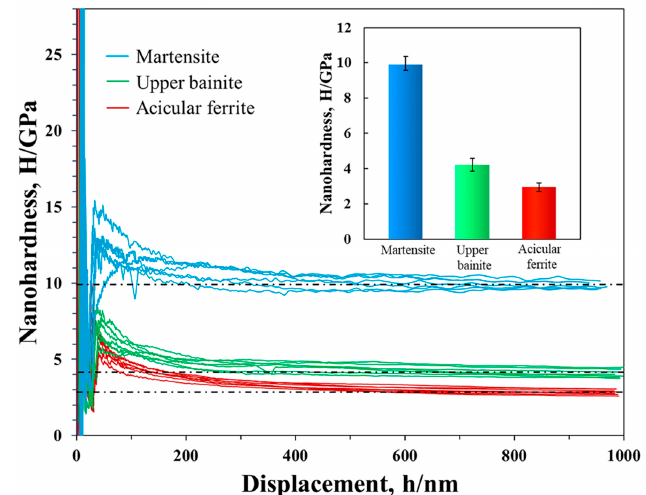
Figure 4. Nanohardness–displacement curves of the three microstructures. Average hardness for each microstructure was drawn from the flat lines in the displacement range between 600 and 1000 nm. The average nanohardness and its error value in each microstructure were shown in the top-right corner. Using our tested average nanohardness values and the Equation (3) derived by Rodriguez et al. based on stress–strain testing, we calculated the yield strength in each microstructure of the surface layer [41]. It was about 2378 ± 123 MPa for lath martensite, 1007 ± 94 MPa for upper bainite, and 706 ± 72 MPa for acicular ferrite. H = 4.15 σ Y (3) where H is nanohardness and σ Y is yield strength. Our low-carbon steel, with only 0.023% carbon content, proved to be able to sustain deformations without permanent deflection under a load of up to 2255 MPa. The high yield strength value of martensite particularly gave the surface layer exceptional resistance to abrasion to a degree that would be unachievable without additional heat treatment in other steels with similar carbon content. 4. Discussion We created an illustration to show the distribution of the three microstructures in the surface layer of our sample (Figure 5). Our steel sheet experienced two key phase transformation stages during the cooling process: 1) liquid to solid transformation, 2) austinite to martensite or ferrite (room-temperature microstructure). The cooling rates during solidification, i.e., during liquid to solid transformation, were calculated to be about 900–1000 K/s at 0–50 μ m depth and about 400–900 K/s at 50–200 μ m depth. The high cooling rate at this stage resulted in a refined high-temperature microstructure in the surface area, such as an average austinite grain size of 152 μ m. The cooling rates at the second stage were estimated to be about 50–100 K/s at 0–50 μ m and about 10–30 K/s at 50–200 μ m. According to the continuous cooling transformation (CCT) curve of a low-carbon steel [42], we deduced the phase transformation that occurred in the hard surface layer.